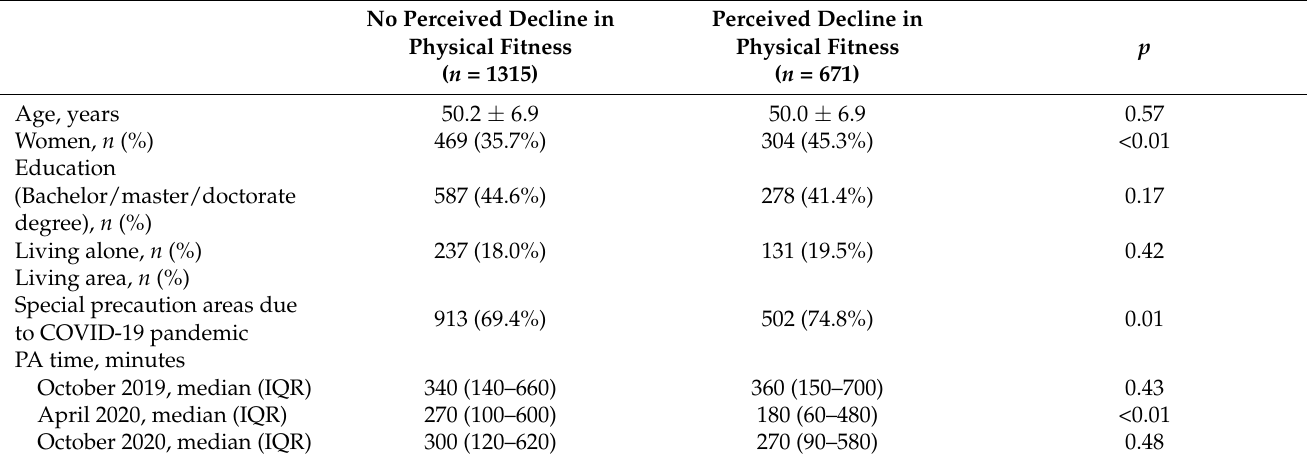
Table 2. Comparison between participants with and without a perceived decline in physical